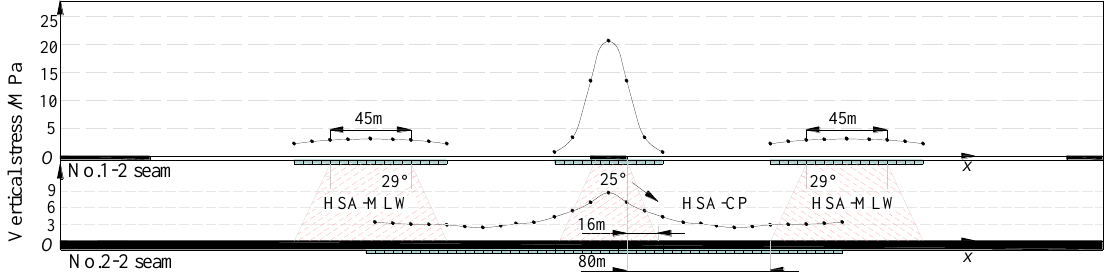
Figure 7. Stress distribution of No. 1 – 2 seam mining.